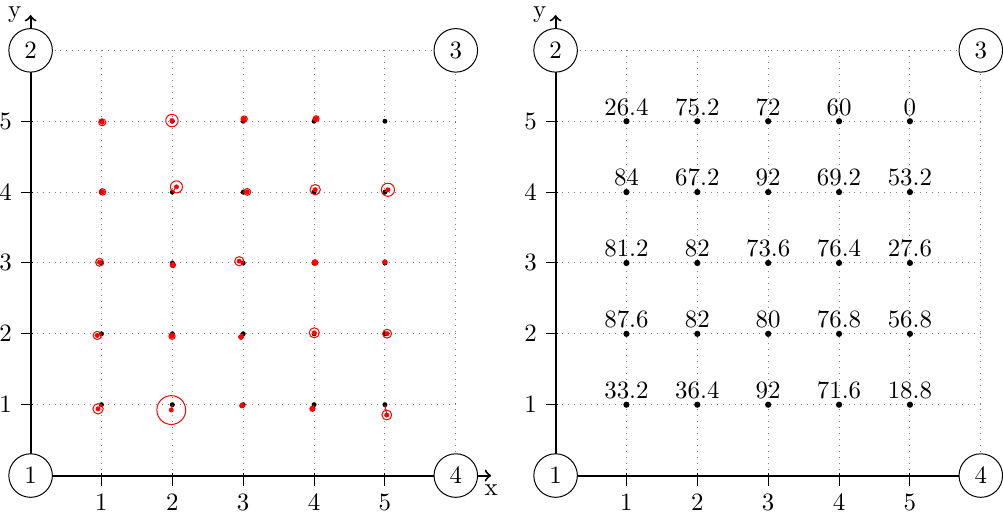
Figure 18. Accuracy and precision of the trilateration process at each point of the grid ( left ); The ratio of successful trilateration attempts ( right ). A total of 250 attempts were issued for each location on the grid. Transmitters are represented by a big circle with the corresponding ID.